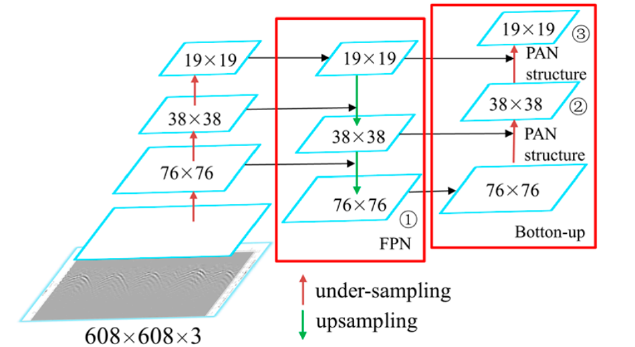
Figure 13. YOLOv5-FPN Structure [45].